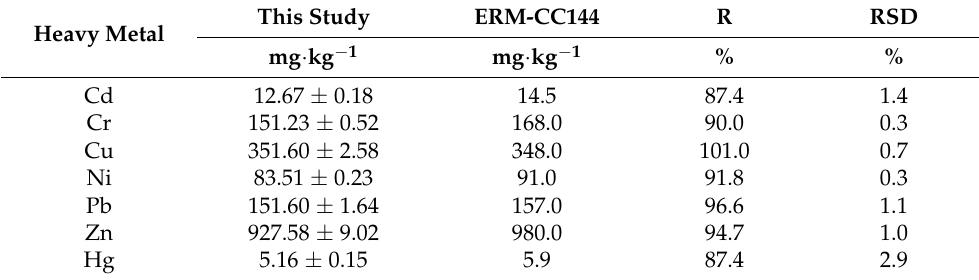
Table 1. Heavy metal concentrations in the ERM-CC144 (JRC) certified reference